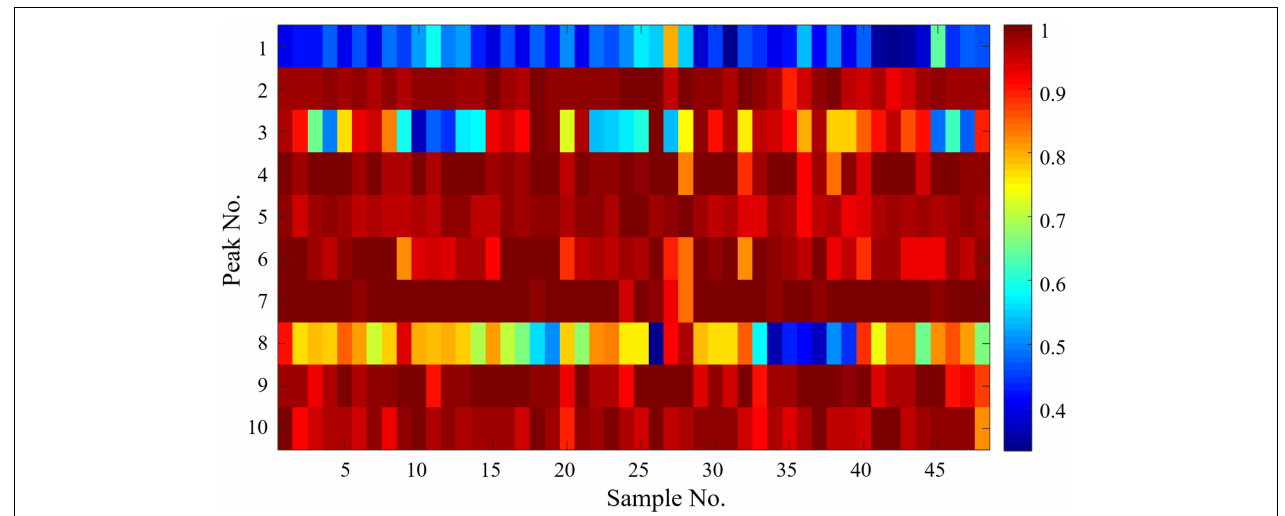
FIGURE 6 | Spectrum-effect relationships between HPLC-CAD fingerprints and anti-inflammatory activities.